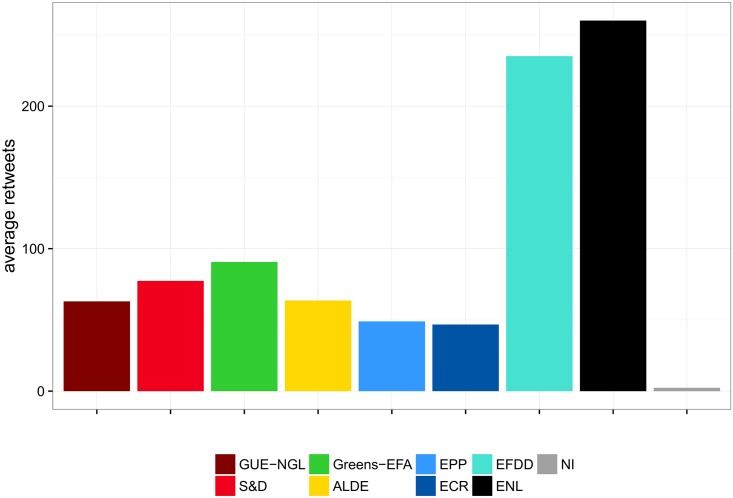
Cohesion of political groups as estimated by retweeting within groups.The average number of retweets within the nine groups is 99.